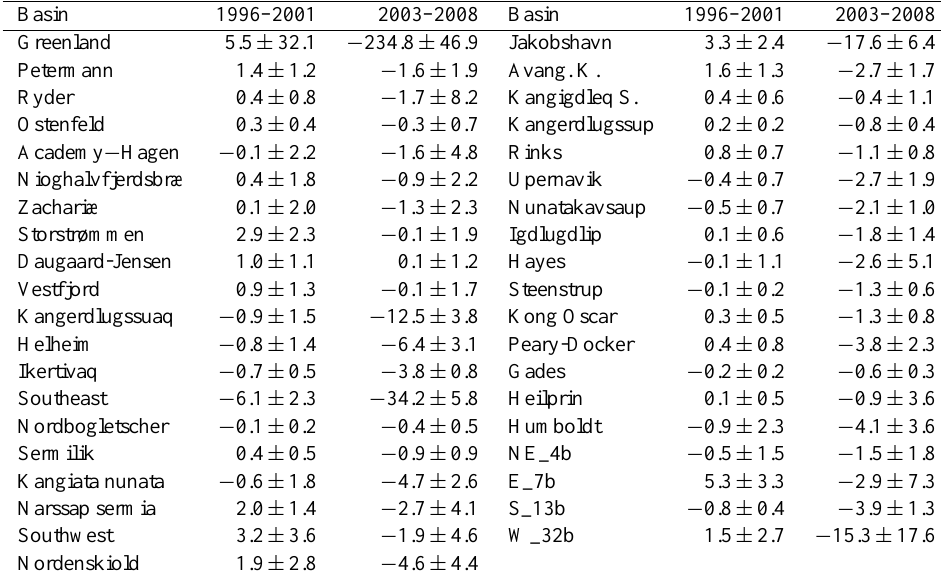
Table 2. d M /d t estimates for two 5-year periods (1996–2001 and 2003–2008) for all 38 drainage basins and the entire GrIS, including estimated errors. Units are Gtyr − 1